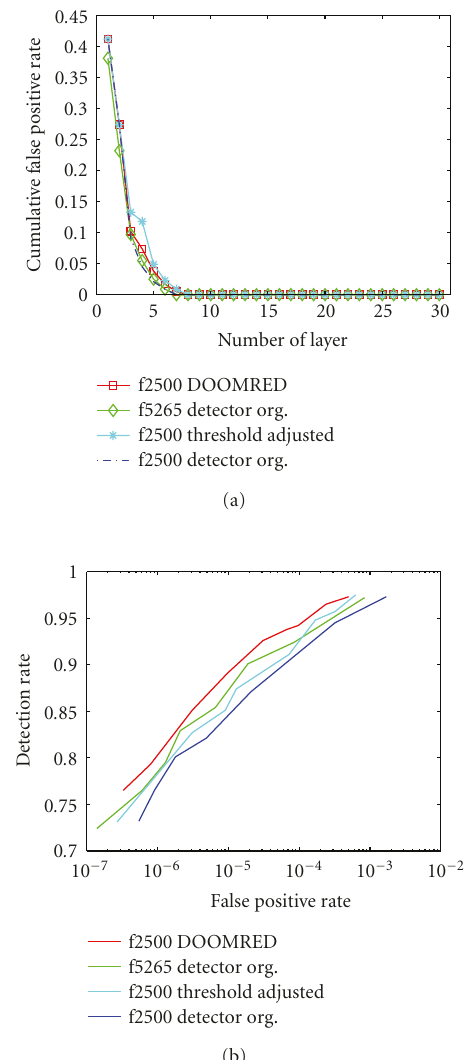
Figure 6: (a) The false positive rates of the boosted cascade frontal face detectors before and after the optimization. (b) ROC curves of the boosted cascade frontal face detectors before and after the optimization estimated on CMU+MIT frontal face test images composed of 130 images containing 507 faces.